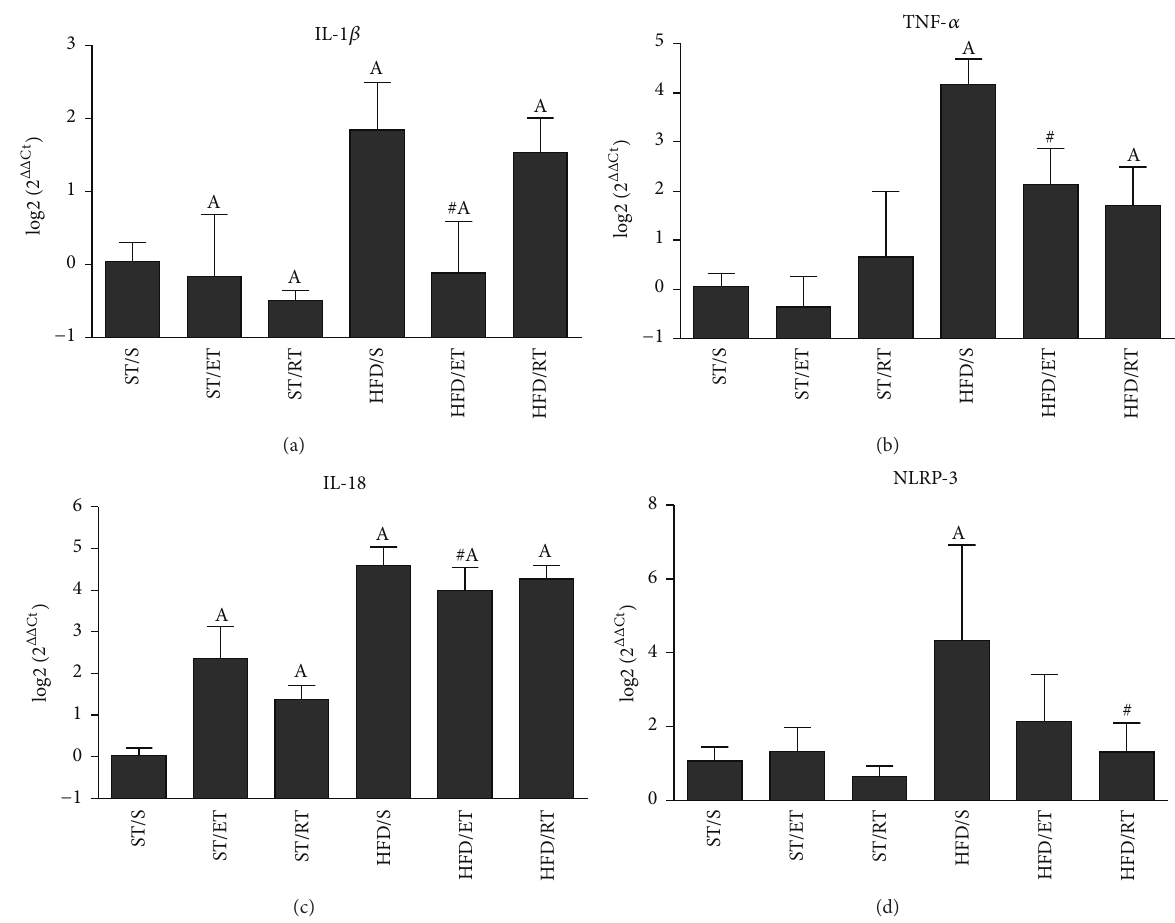
Figure 4: Adipose tissue mRNA expression of IL-1 𝛽 (a), TNF- 𝛼 (b), IL-18 (c), and NLRP-3 (d) in sedentary and exercised groups of animals fed a standard or a high fat diet. Delta delta Ct ( ΔΔ Ct) values were calculated by subtracting the mean Δ Ct of ST/S (control) from the Δ Ct of each examined sample. Statistical comparison was performed on Δ Ct of each group. Data are shown as log2 ( 2 ΔΔ Ct ) values. A: comparison between ST diet groups and corresponding HFD group ( 𝑝 < 0.05 ), #: comparison between sedentary HFD group and the exercised HF groups, ST: standard diet, HFD: high fat diet, S: sedentary, ET: endurance training, and RT: resistance